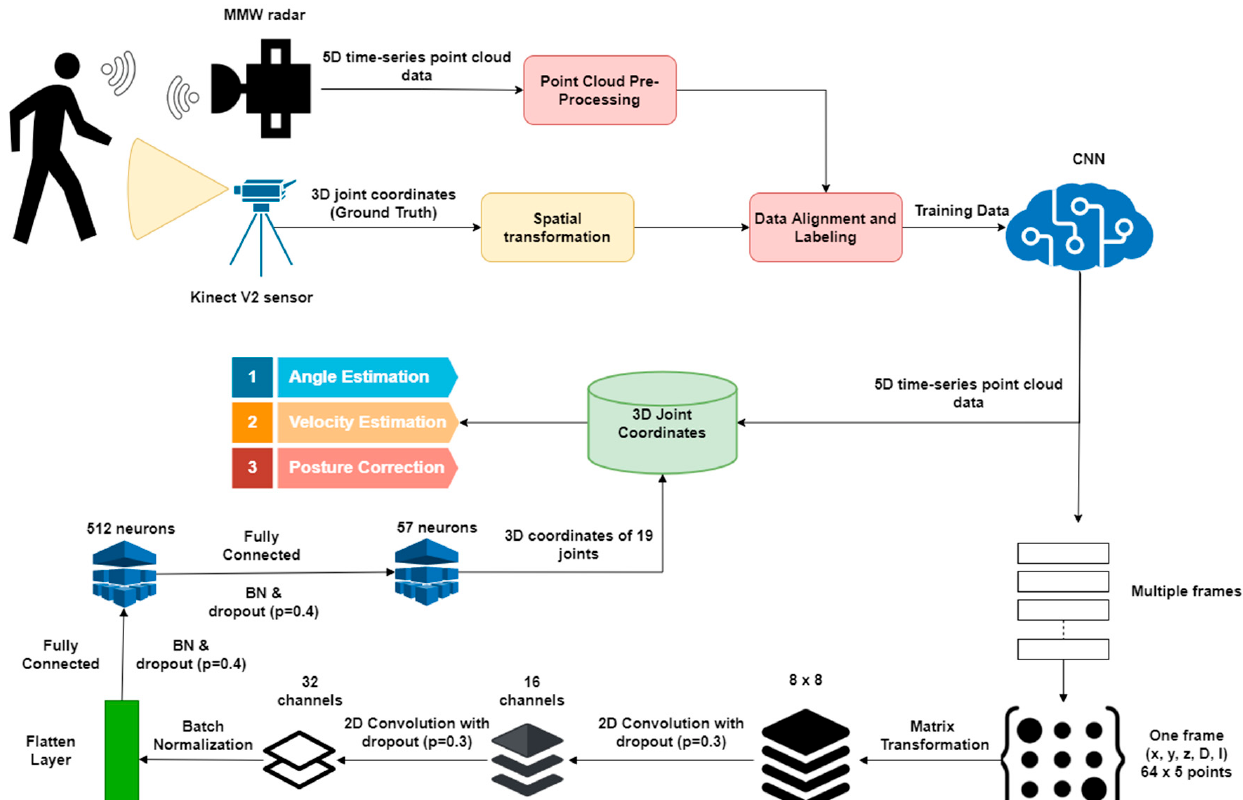
Figure 6. Joint estimation using the 5D time-series point cloud.